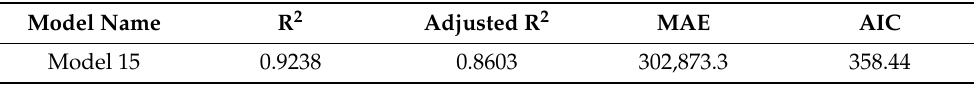
Table 11. Data for the model with interactions (Model